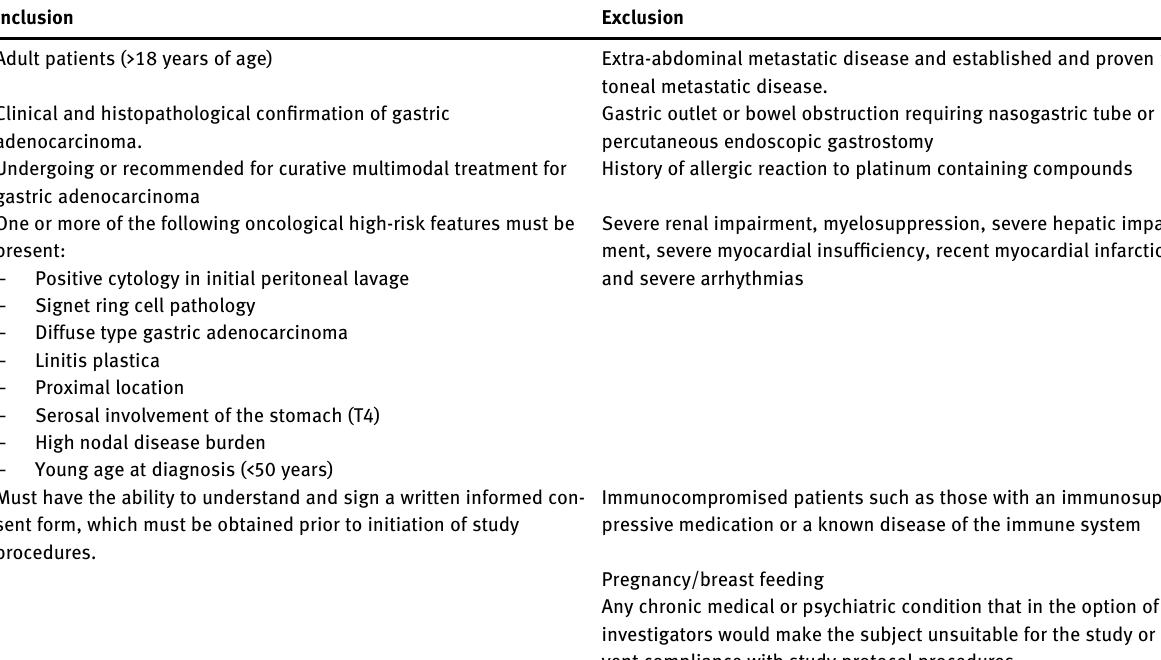
Table  : Inclusion and exclusion criteria for PIPAC-O + protocol. Inclusion Exclusion Adult patients (>  years of age) Extra-abdominal metastatic disease and established and proven peri- toneal metastatic